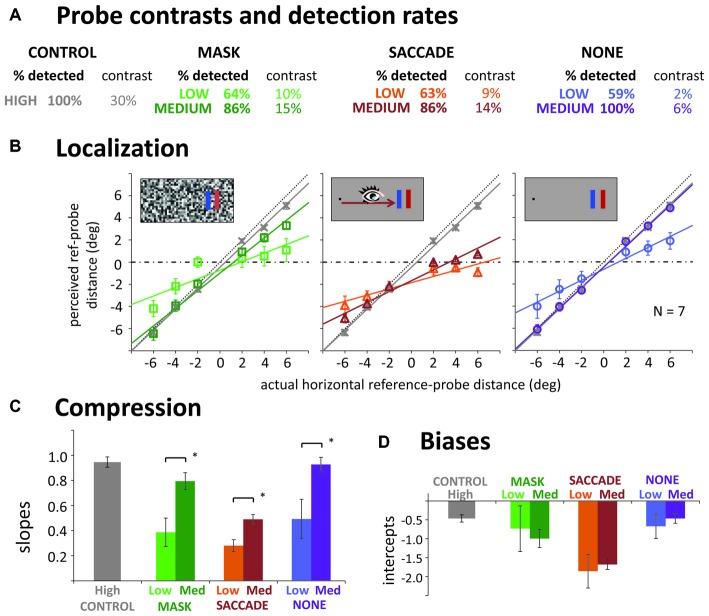
Results of Experiment 2. (A) Detection rates and mean contrast levels for the probes in low and medium contrast conditions. Contrast was varied along a combined luminance and color contrast scale (see Figure 1); for simplicity, only luminance (Michelson) contrast is reported here. (B) Actual vs. average reported reference-probe distances (mask, saccade, none) and the corresponding linear fits, separate for low contrast (pale symbols) and medium contrast trials (dark symbols). Gray data in each panel illustrate the high contrast control. (C,D) Slopes and intercepts of the linear regression lines. All error bars: standard error of the mean. *p < 0.05.